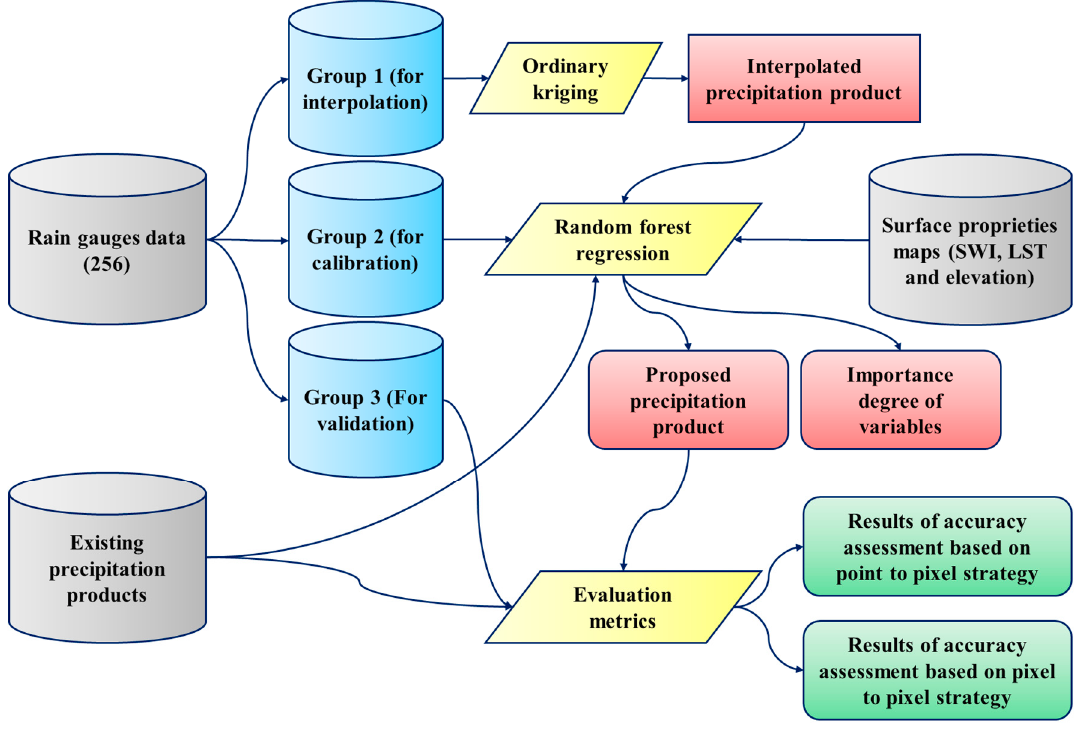
Figure 2. Conceptual framework of the